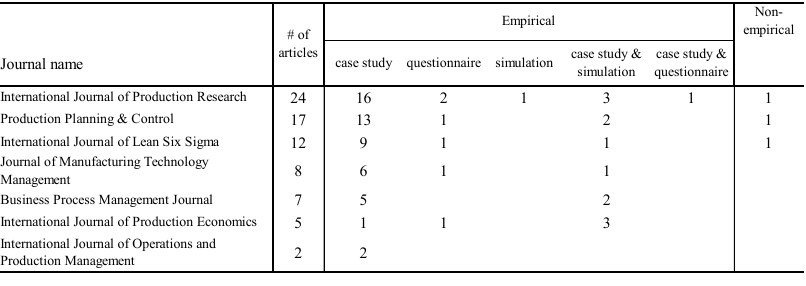
Table 1. Distribution of method of VSM